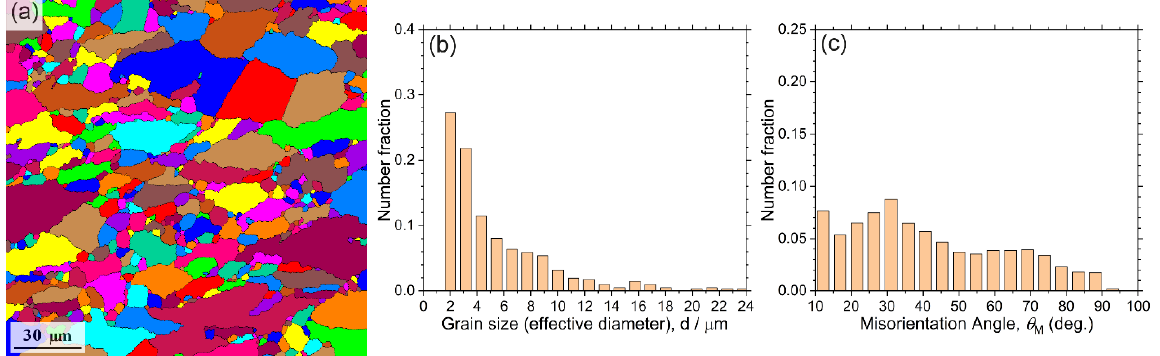
Figure 5. Initial microstructure of the Mg-1Zn-0.2Ca alloy ( a ) and its parameters: ( b )—grain size distribution; ( c )—distribution of the angles of misorientation between grains.